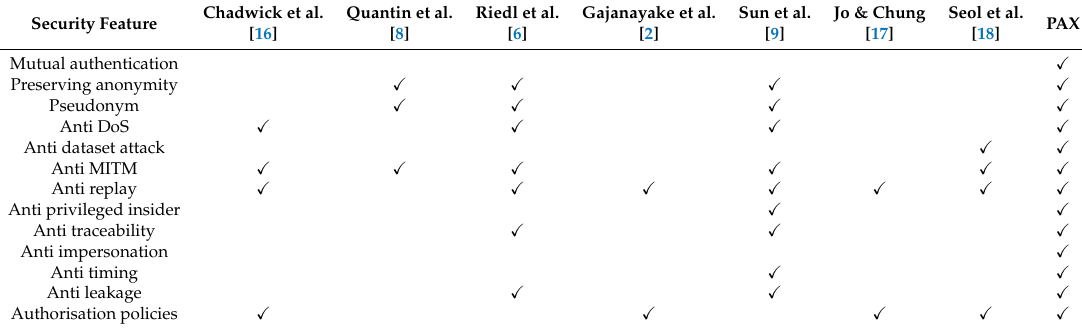
Table 3. Comparison of security